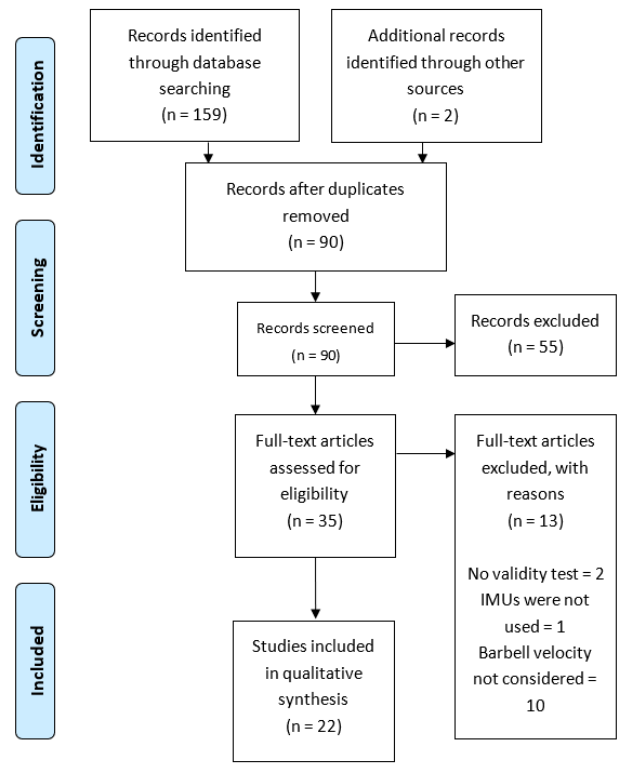
Figure 1. Preferred Reporting Items for Systematic Reviews and Meta-Analyses (PRISMA) flow diagram.